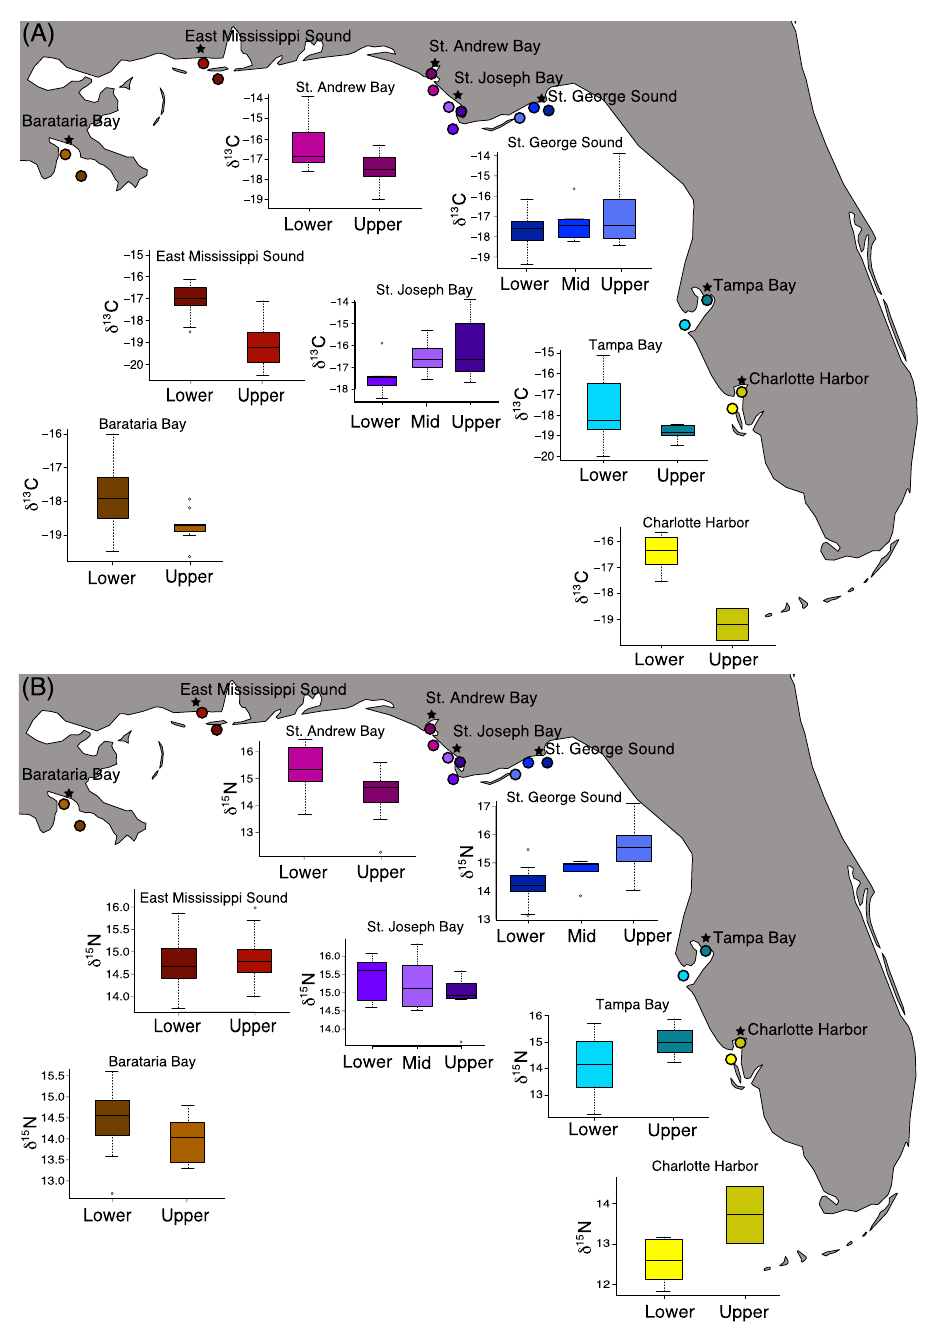
Figure 3. Within site variation in δ 13 C ( A ) and δ 15 N ( B ) values. Maps were generated using the ggmap package (version 3.0.0) in R 106